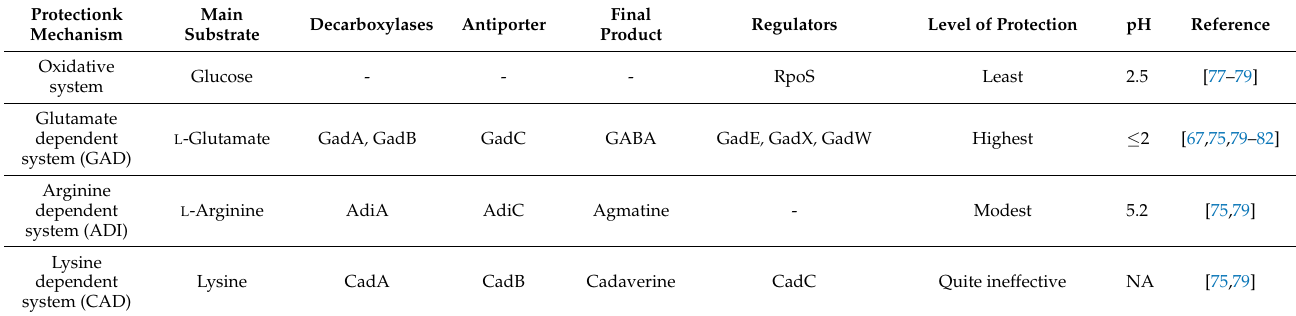
Table 1. Overview of the genes involved in acid resistance regulatory systems in E. coli